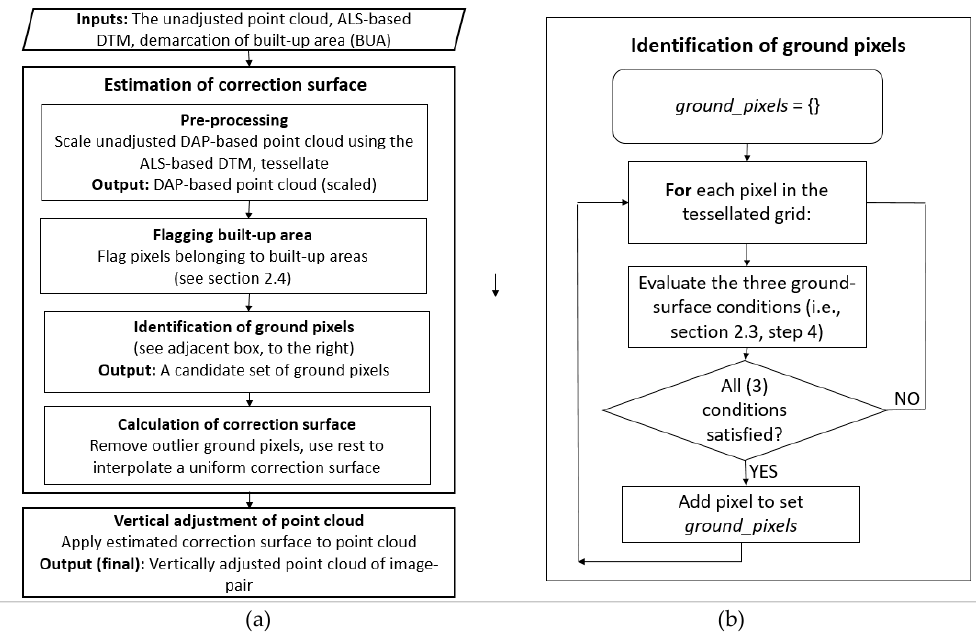
Figure 2. ( a ) Pictorial representation of the salient steps of our method, to be applied to each image pair. ( b ) Steps for the identification of ground pixels.